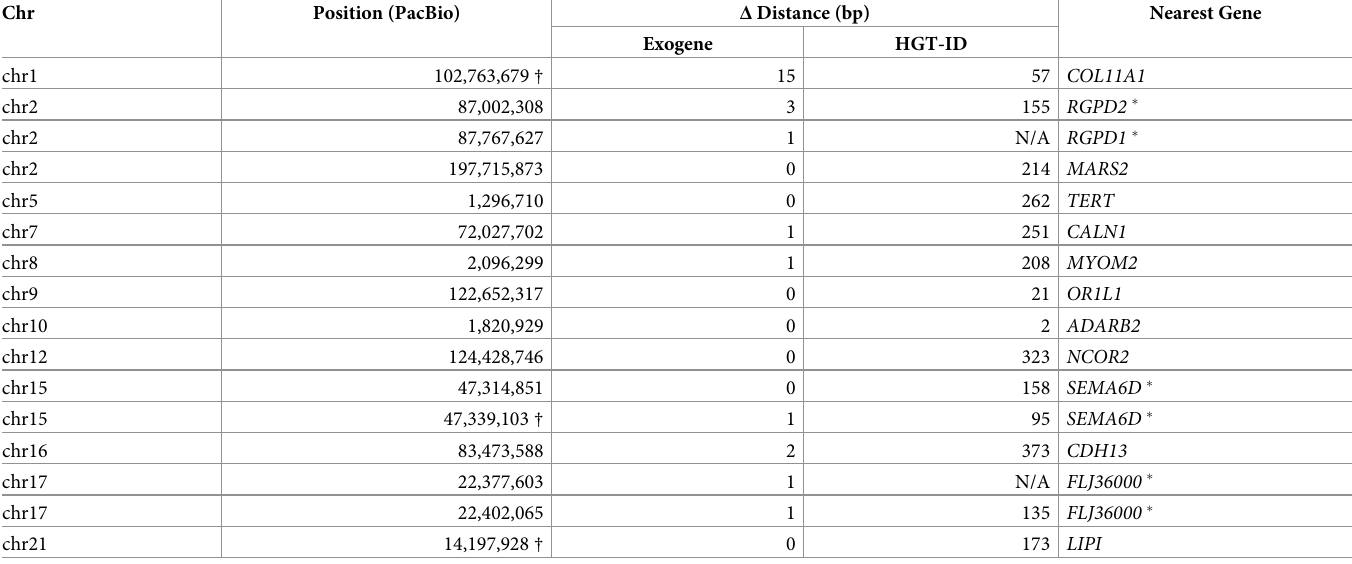
Table 1. Overview of HBV integration sites in